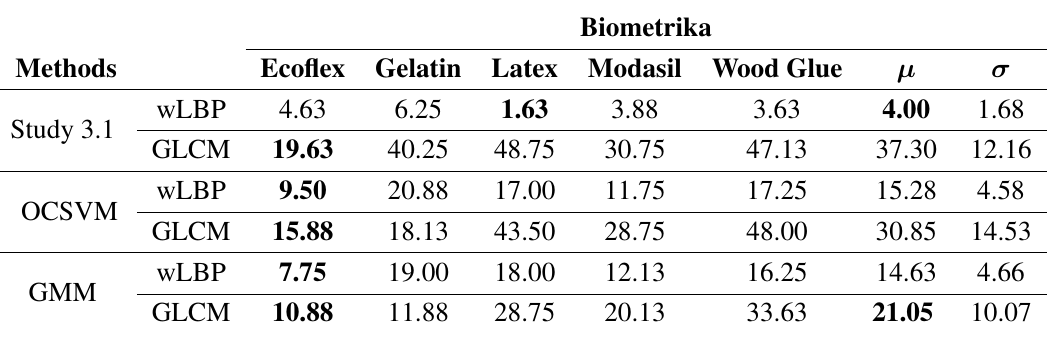
Table 9. ACER for the Biometrika dataset, study 3 (ACER in %